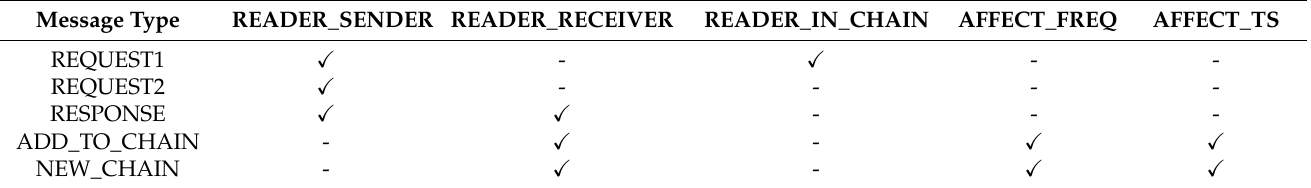
Table 2. Proposed control message structure .